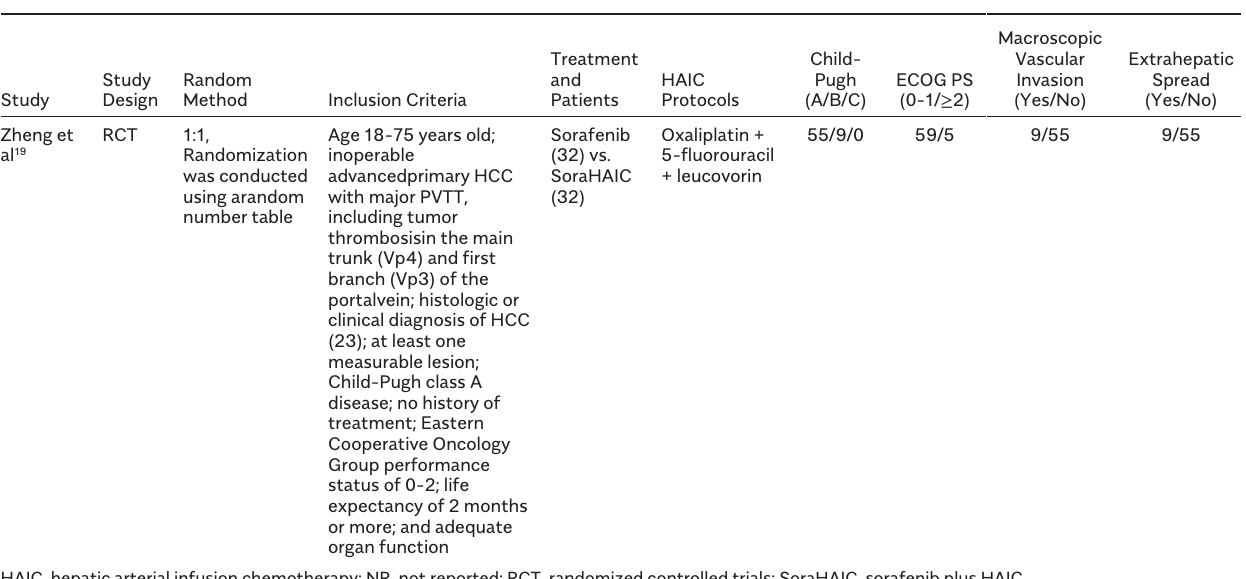
Table 1. Baseline Characteristics of Included Studies in the Meta-analysis ( Continued )